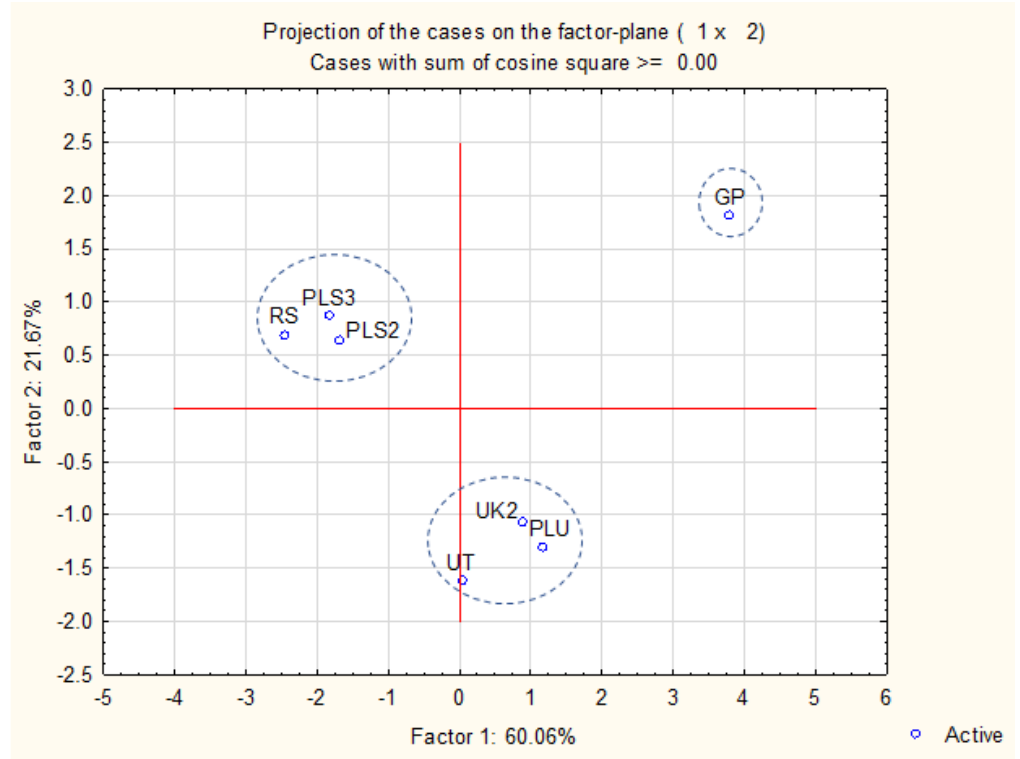
Figure 3. Projection of the cases on the factor plane in a two-component model.